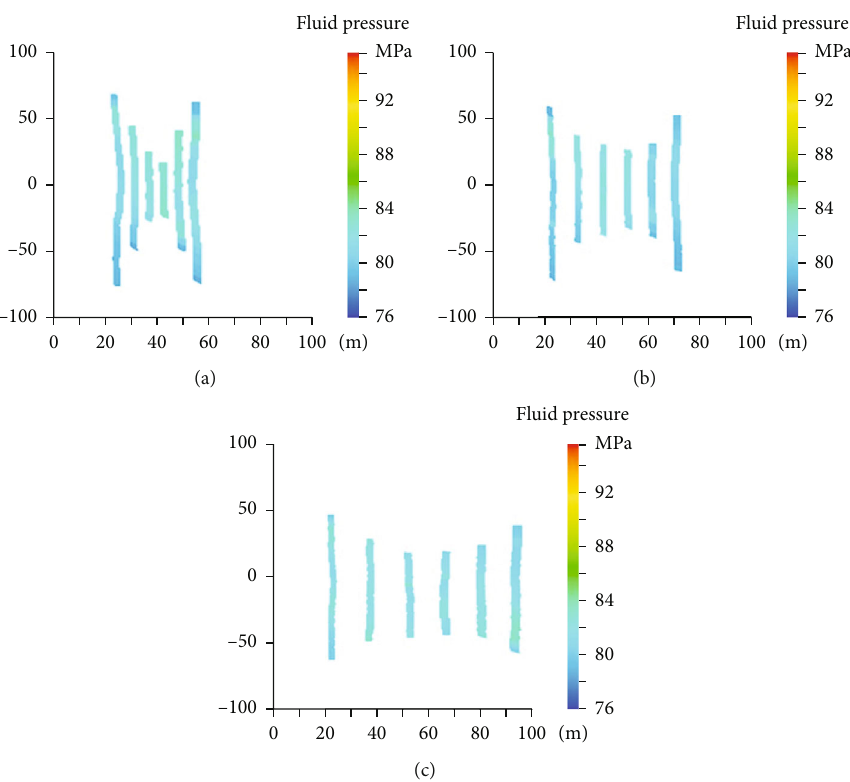
Figure 5: E ff ects of di ff erent cluster spacing on fracture geometry: (a) cluster spacing 5m, (b) cluster spacing 10 m, and (c) cluster spacing 15m.